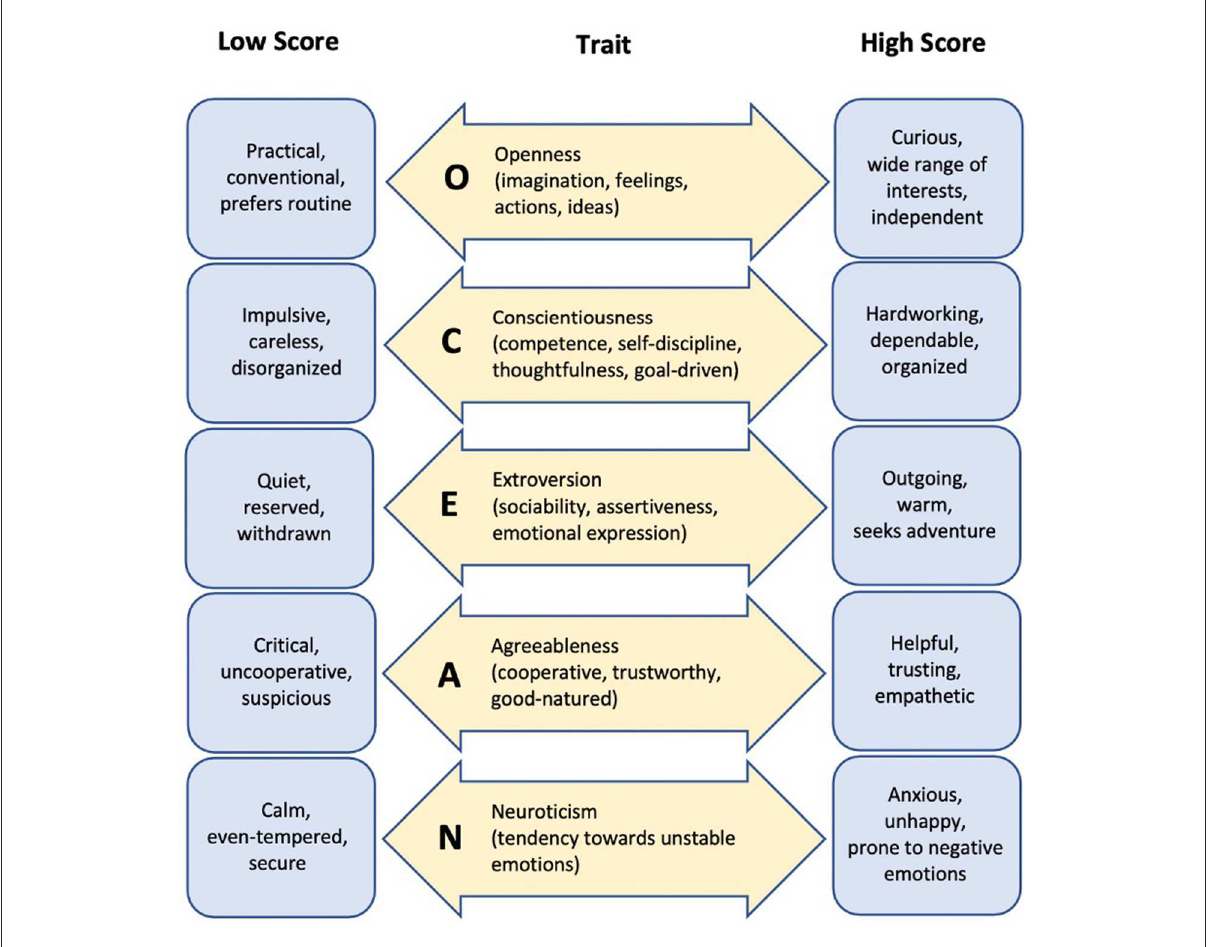
FIGURE1 The Big Five personality traits, following Gray